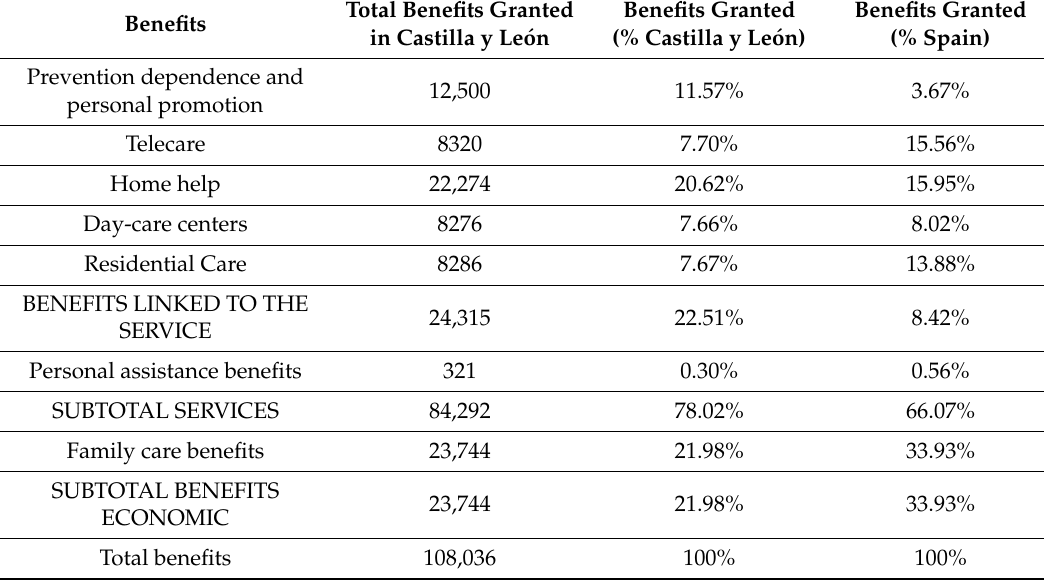
Table 5. Distribution by kind of social health benefit and percentage of total benefits granted in Castilla y Le ó n and